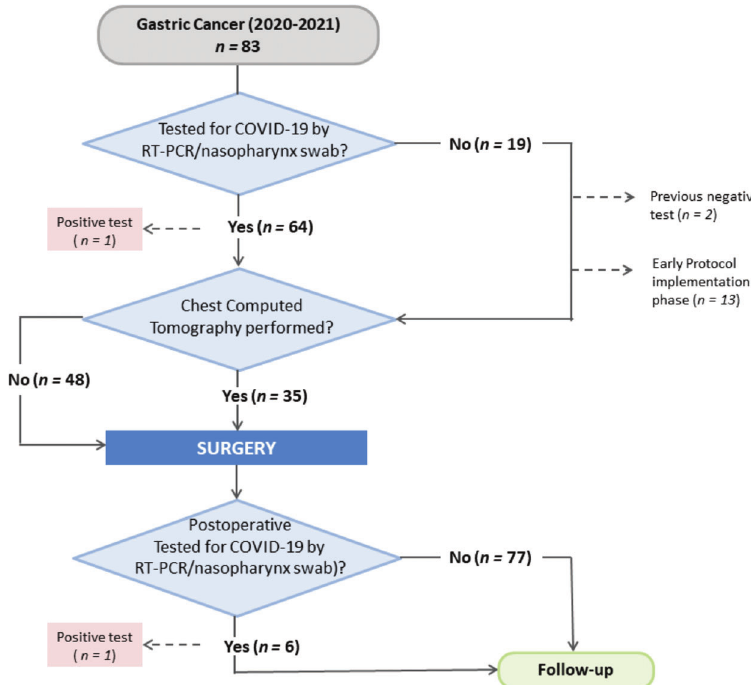
Figure 2 - Flowchart illustrating the COVID-19 screening protocol employed at the